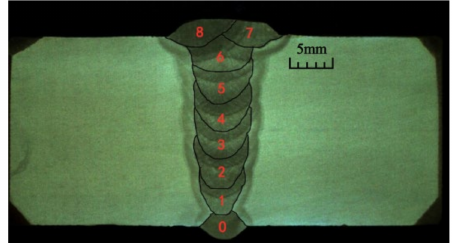
Figure 2. Narrow gap groove